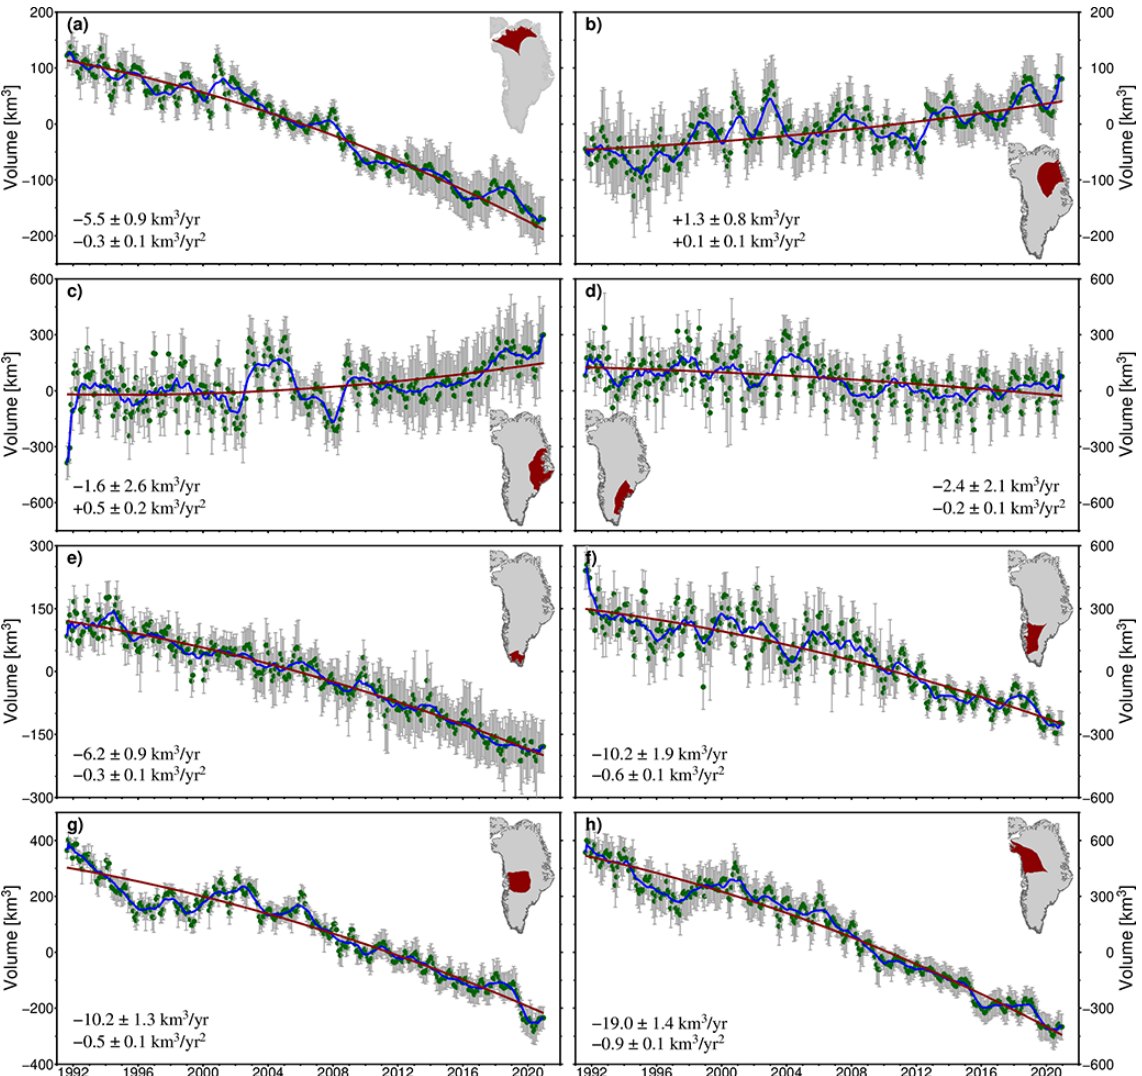
Figure 9. Volume change of sub-regions south of 81.5 ◦ N from our merged altimetric time series (green dots) and their corresponding results after removing seasonal oscillations using a 13-month moving average (blue solid curves). The solid red lines are the best-fit quadratic curves for the linear- and quadratic-trend estimates of volume change. The grey error bars show the 1 σ uncertainty range of the altimetry data. The red-shaded area in the inset of each panel indicates the coverage of the sub-region with reference to the Greenland drainage system boundaries in Zwally et al.